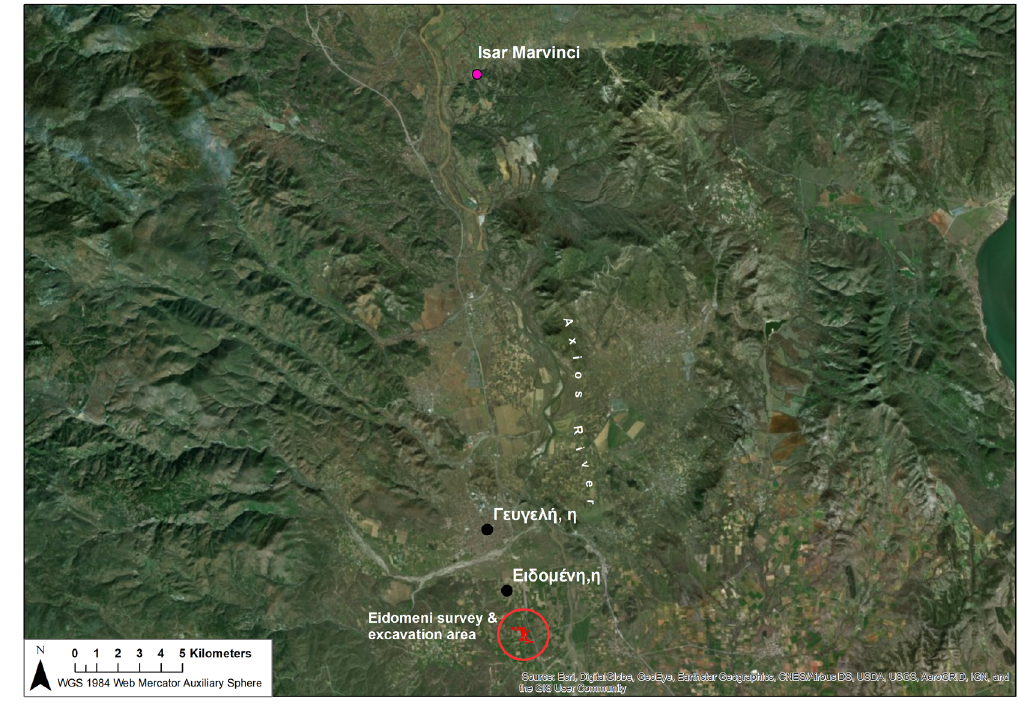
Figure 5. Isar Marvinci and modern Idomeni (WGS 1984, WebMercator Auxiliary